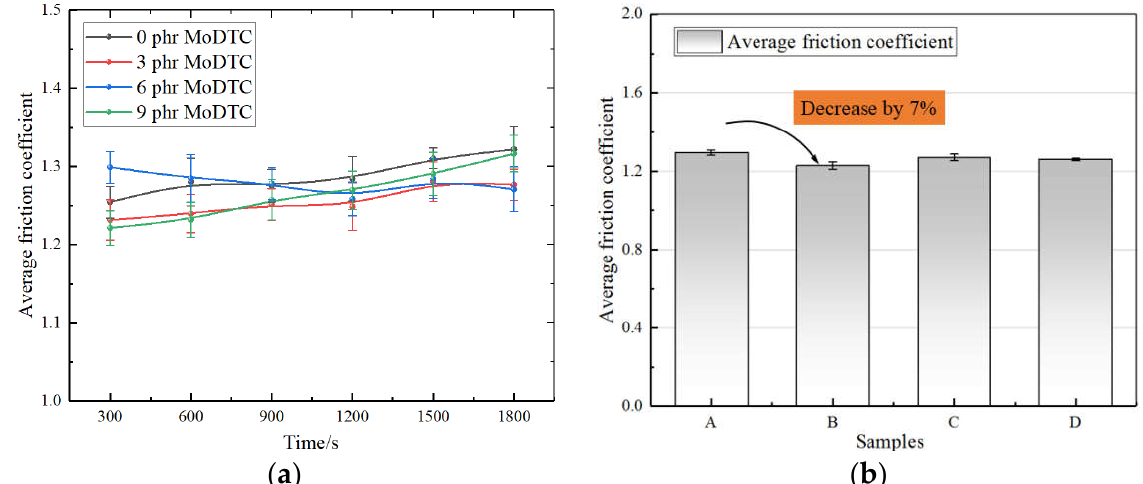
Figure 3. The comparison of the average friction coefficient and friction coefficient change between the four samples and metal. ( a ) Friction coefficient change. ( b ) Comparison of the average friction coefficient (A: 0 phr MoDTC;B: 3 phr MoDTC; C: 6 phr MoDTC;D: 9 phr MoDTC).